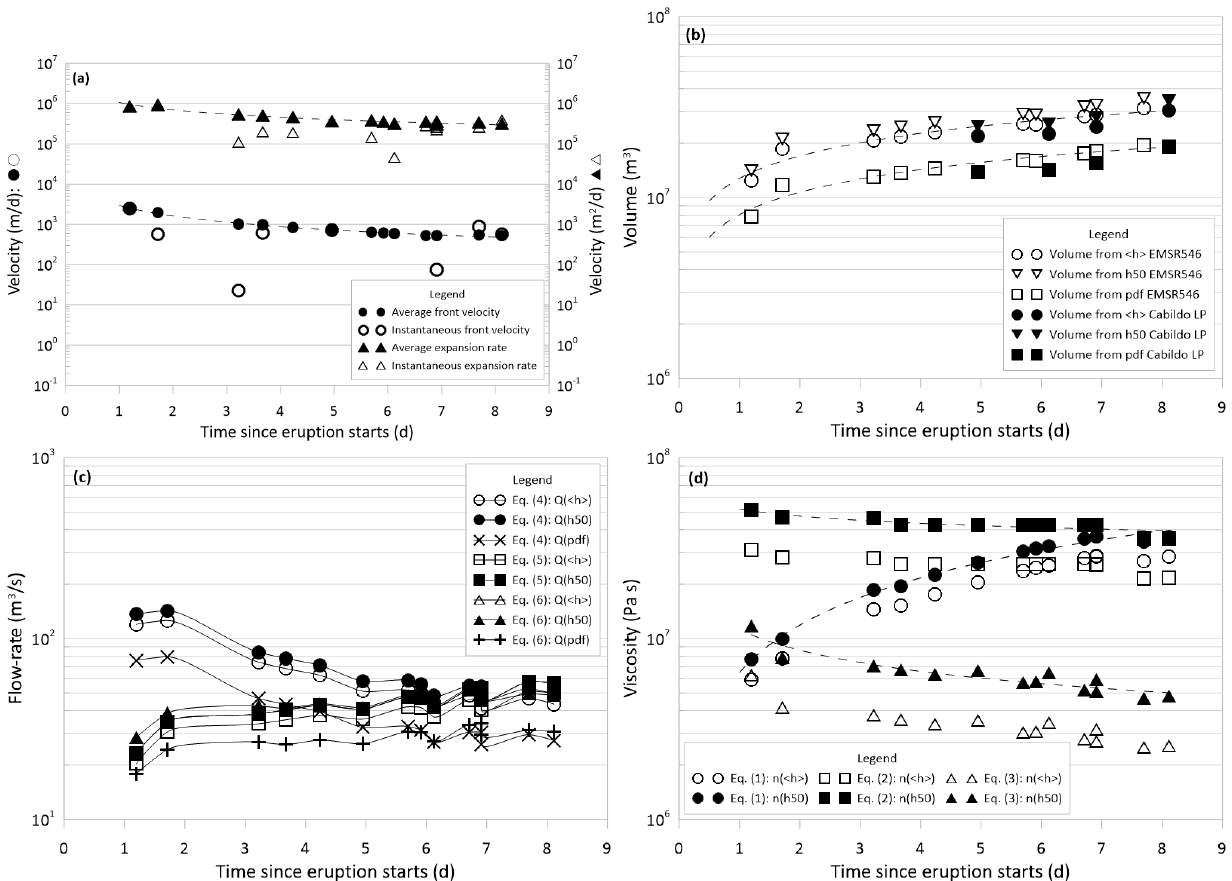
Figure 5. Temporal evolution estimated from morphometric analysis from the beginning of the eruption until 25 September of: ( a ) average and instantaneous velocity of the lava front and lava flow expansion; ( b ) lava flow volume V ; ( c ) lava flow emission rate Q ; and ( d ) apparent viscosity η . Dashed lines are explained in the